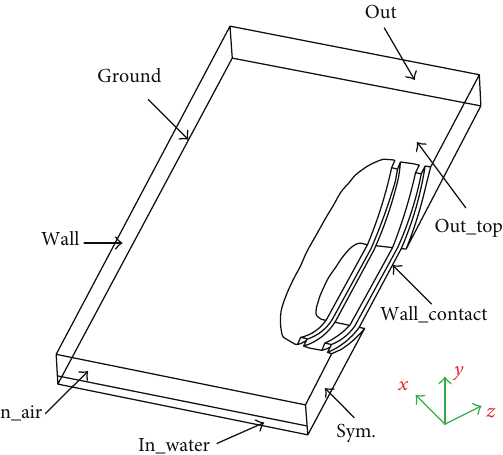
Figure 2: The computational model and boundary conditions.